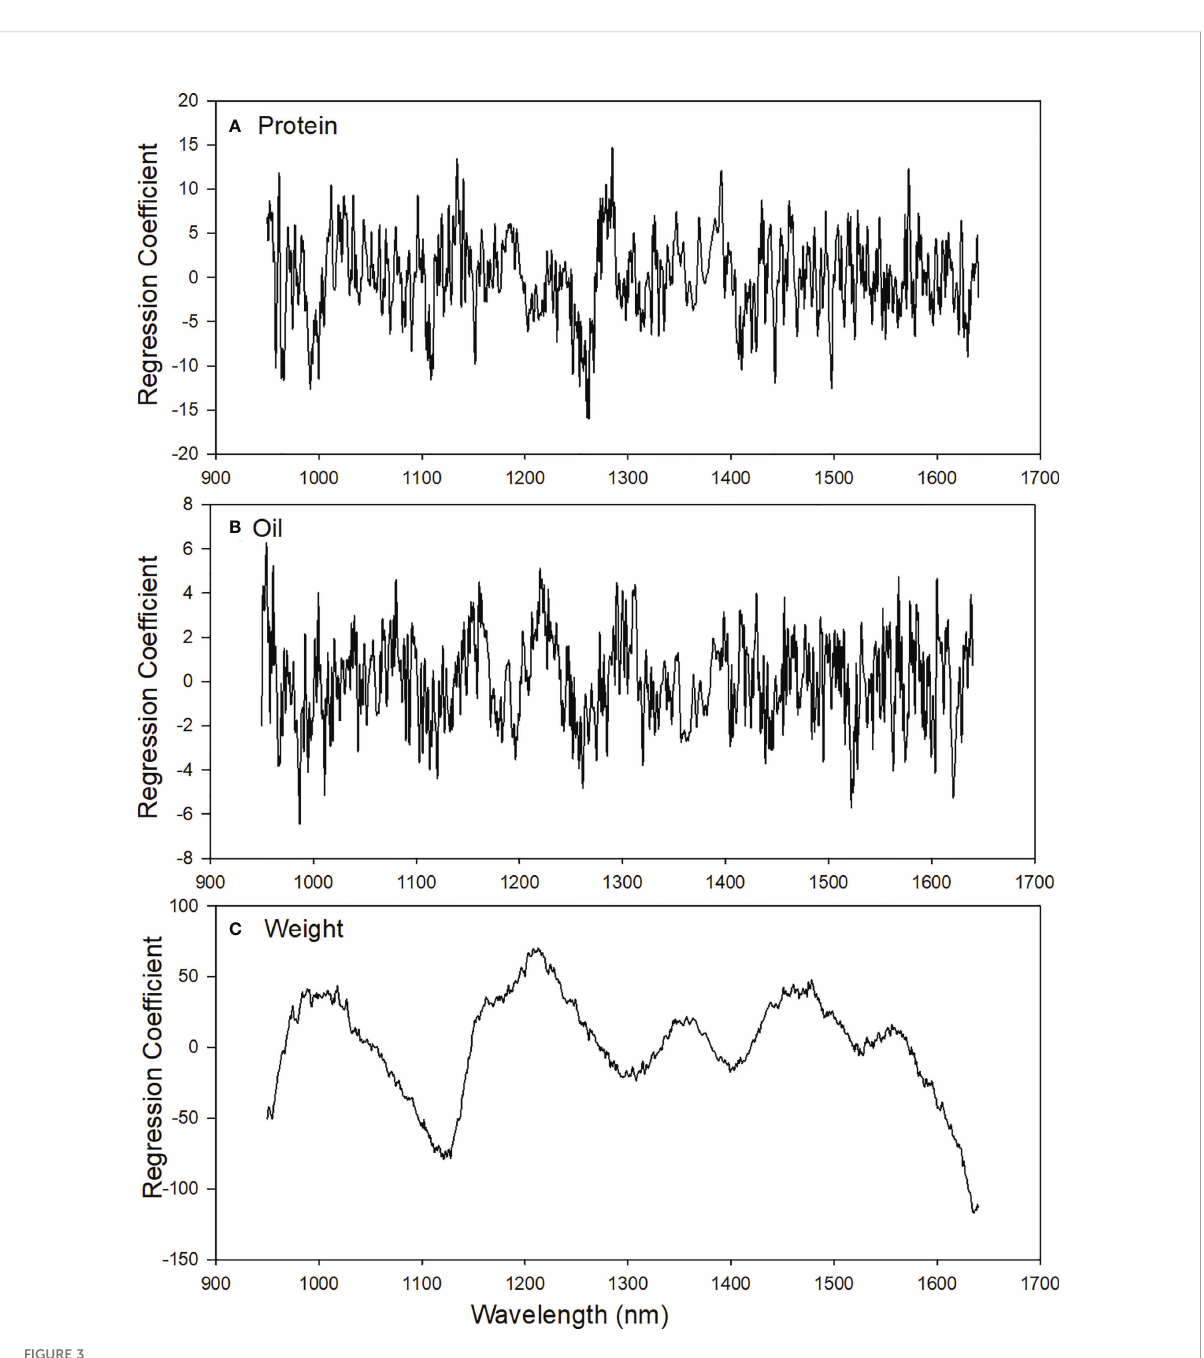
FIGURE 3 Examples of contrasting spectra of high- and low-contents of (A) protein, (B) Oil, and (C) weight in sorghum